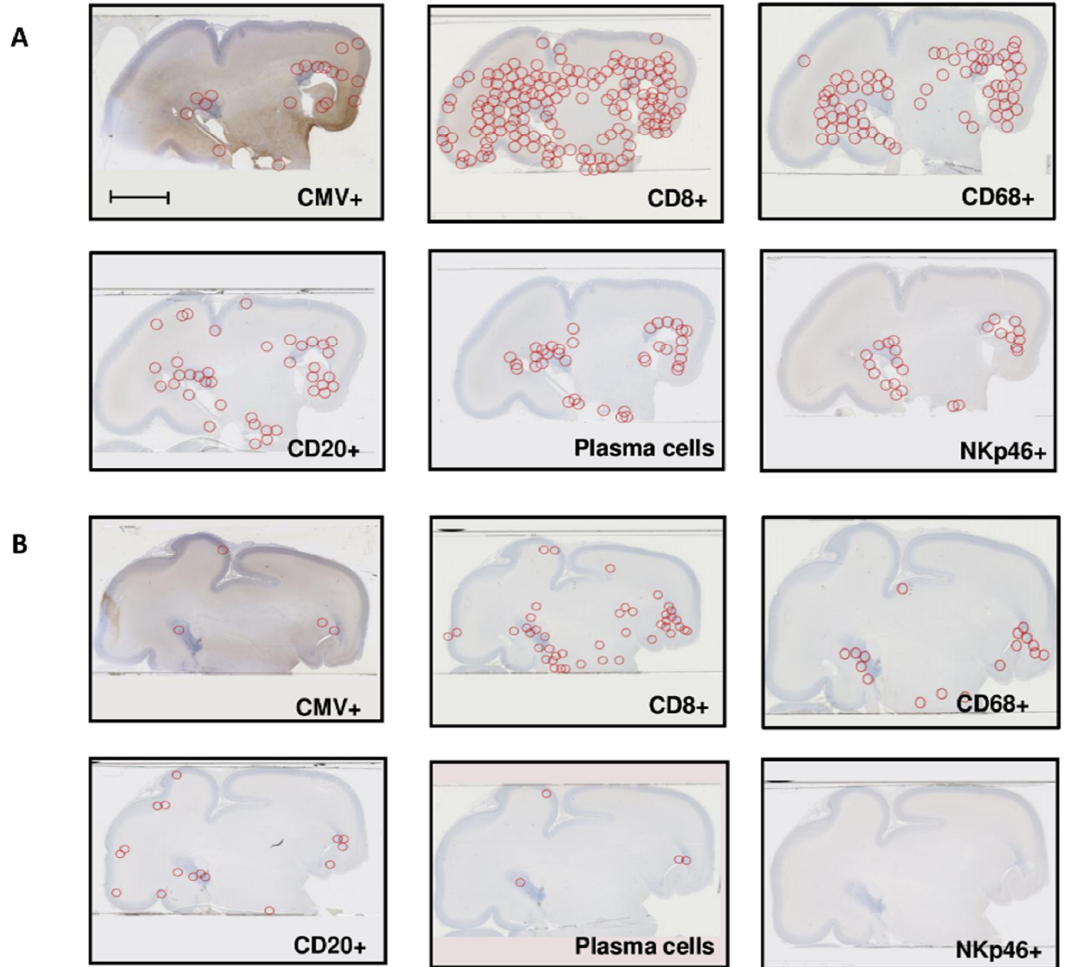
Figure 2. Repartition of HCMV-positive cells and immune cells ( A ) in one severely affected fetal brain sample (group A), successive cuts (case 8), and ( B ) in one moderately affected fetal brain sample (group B), successive cuts (case 17). Scale bar 35mm